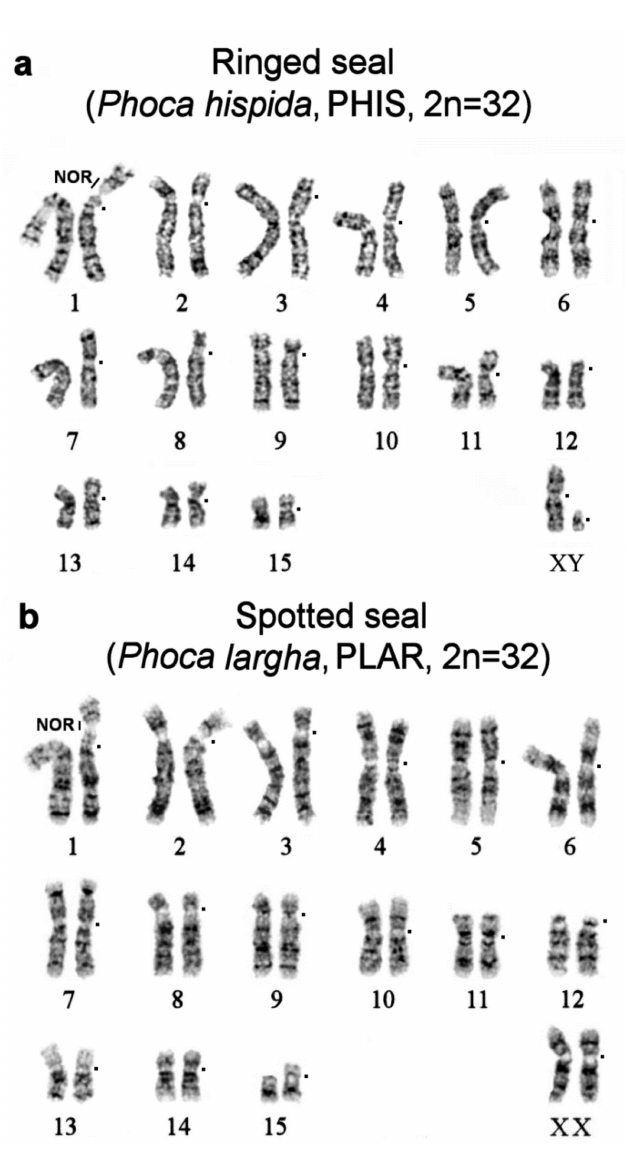
Figure 2. The GTG banded karyotype of ( a ) the ringed seal (PHIS, 2n = 32) and ( b ) spotted seal (PLAR, 2n = 32). The square denotes a centromere position. Sites of rDNA gene clusters are marked as